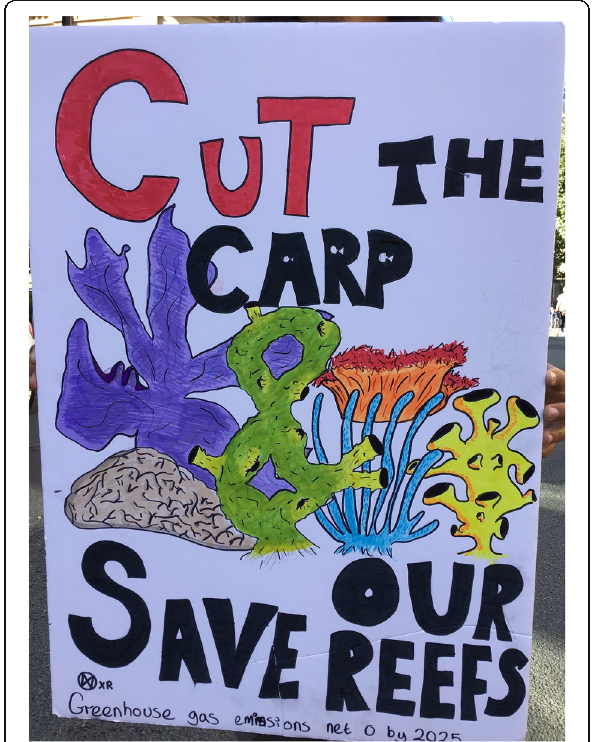
Fig. 5 Protest sign: 'CUT THE CARP & SAVE OUR REEFS Greenhouse gas emissions net 0 by